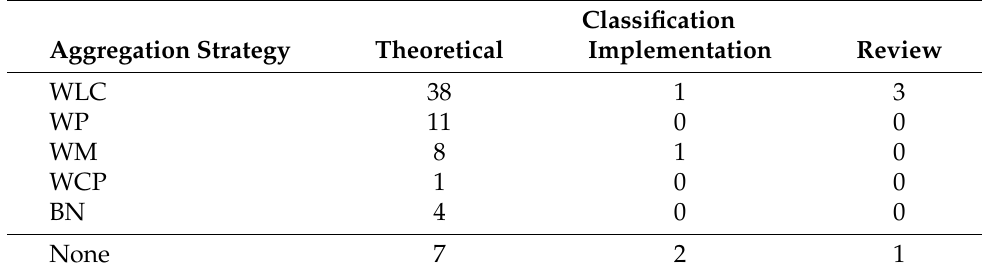
Table 8. Different aggregation strategy classes and the situations in which they were employed.